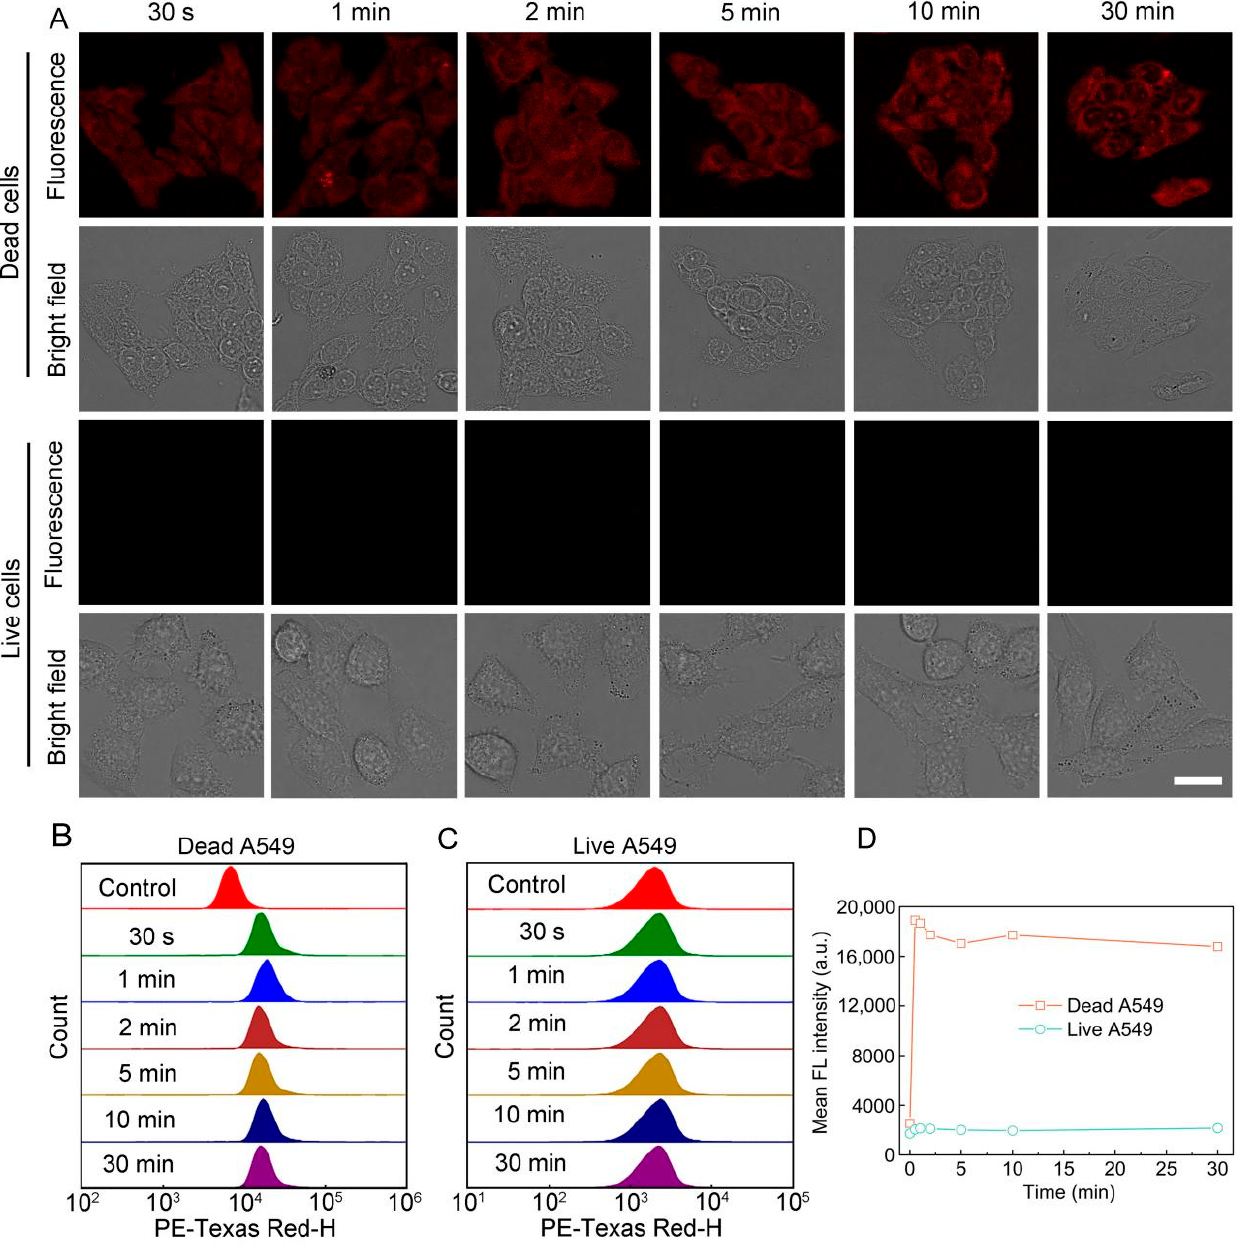
Figure 10. ( A ) Confocal images of dead and live A549 cells treated with S ‐ OSiNDs (5 μ g/mL) for different time periods. Scale bar = 25 μ m. Flow cytometric results of dead ( B ) and live ( C ) A549 cells incubated without (control) or with S ‐ OSiNDs (5 μ g/mL) for different time periods and ( D ) corre ‐ sponding quantitative mean fluorescence intensities derived from the flow cytometric results.